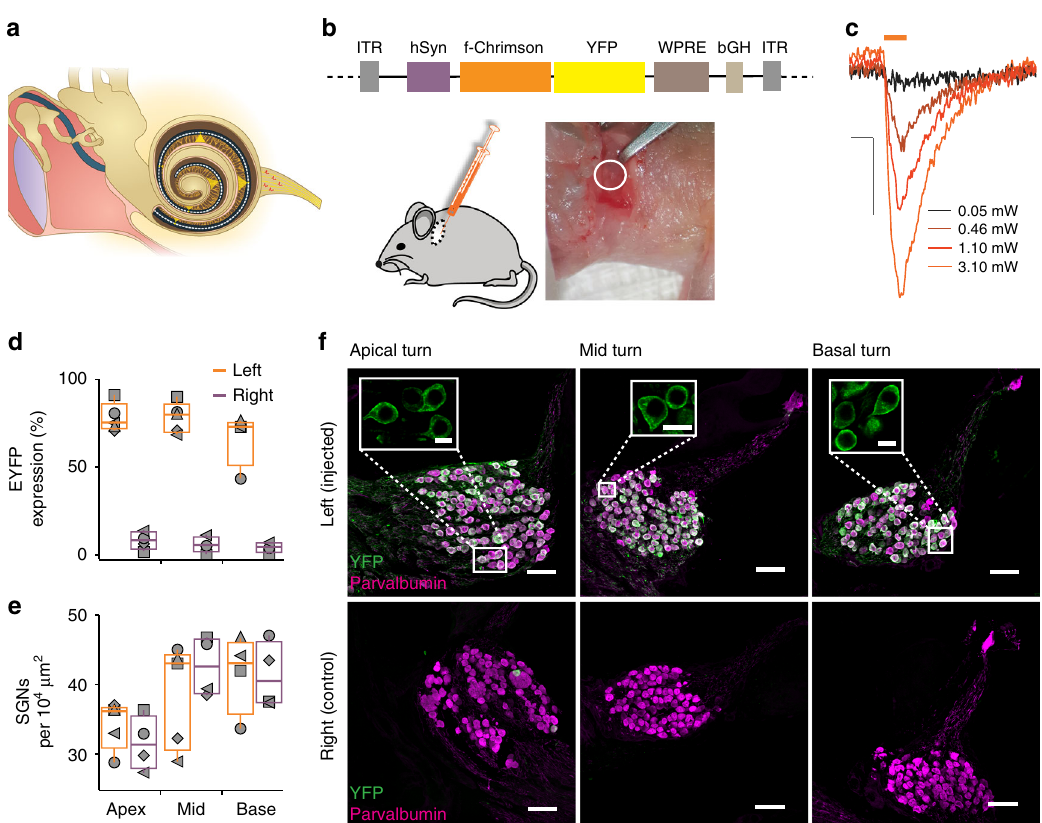
Fig. 4 f-Chrimson expression after postnatal AAV-transduction of SGNs. a Scheme of the future oCI as implanted into the human ear: the oCI passes through the middle ear (limited left by ear drum and right by inner ear) near the ossicles, enters the cochlea and spirals up in scala tympani. It will likely contain tens of microscale emitters (orange spots on oCI) that stimulate (orange beams) SGNs housed in the modiolus (central compartment of the cochlea), that encode information as APs. SGNs form the auditory nerve (right) which carries the information to the brain (not displayed). b pAAV vector used in the study to express f-Chrimson-EYFP under the control of the hSynapsin promoter (top) upon early postnatal injection of AAV2/6 into scala tympani via a posterior tympanotomy (lower left) to expose the round window (white circle in right lower panel). c Photocurrents of a representative culture f-Chrimson-EYFP-positive SGN isolated from an injected ear at postnatal day 14. Light pulses of 2 ms duration were applied at the indicated intensities in the focal plane and photocurrents recorded at − 73 mV at room temperature. Scale bar: 2 ms, 50 pA. d Fraction of EYFP-positive (EYFP + ) SGNs (identi fi ed by parvalbumin immuno fl uorescence, parvalbumin + ) and e density of parvalbumin + SGNs (#cells per 10 4 µ m 2 ) obtained from data as in f . Symbols mark results from individual animals ( n = 5), box – whisker plots show 10th, 25th, 50th, 75th and 90th percentiles of the injected (orange) and non-injected control (magenta) cochleae (Kruskal – Wallis ANOVA, P = 0.6538, H = 0.98; post-hoc Dunn ’ s test for comparison of expression, P > 0.05 for all pairwise comparisons; Mann – Whitney U test for comparison of density, L apex vs. R apex , L mid vs. R mid , L base vs. R base , P > 0.05 for all comparisons). f Projections of confocal cryosections with YFP (green) and parvalbumin (magenta) immuno fl uorescence of SGNs in three cochlear regions (scale bar: 50 µ m). Insets (scale bar: 10 µ m) show close-up images of single z-sections of the